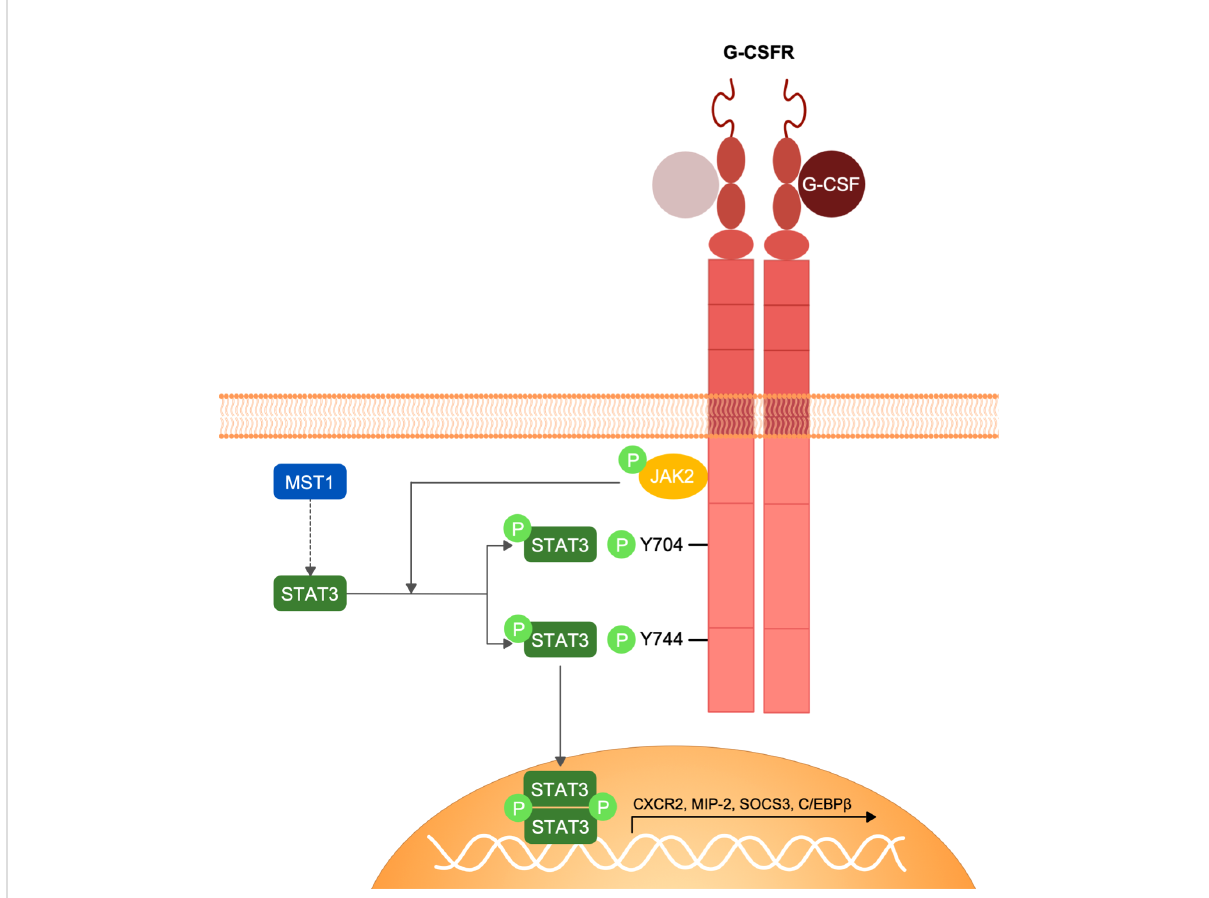
FIGURE 5 Schematic representation of G-CSFR signalling and MST1-dependent regulation of STAT3 phosphorylation. G-CSF interaction with G-CSFR induces the homo-dimerization of the receptor and the conformational change of its intracellular domain that favours the activation of JAK2 by trans-phosphorylation. JAK2 in turn phosphorylates G-CSFR and STAT3. STAT3 phosphorylation by JAK2 following G-CSFR stimulation is regulated by MST1 indicating an important role of MST1 in the G-CSF/JAK2-STAT3 signaling